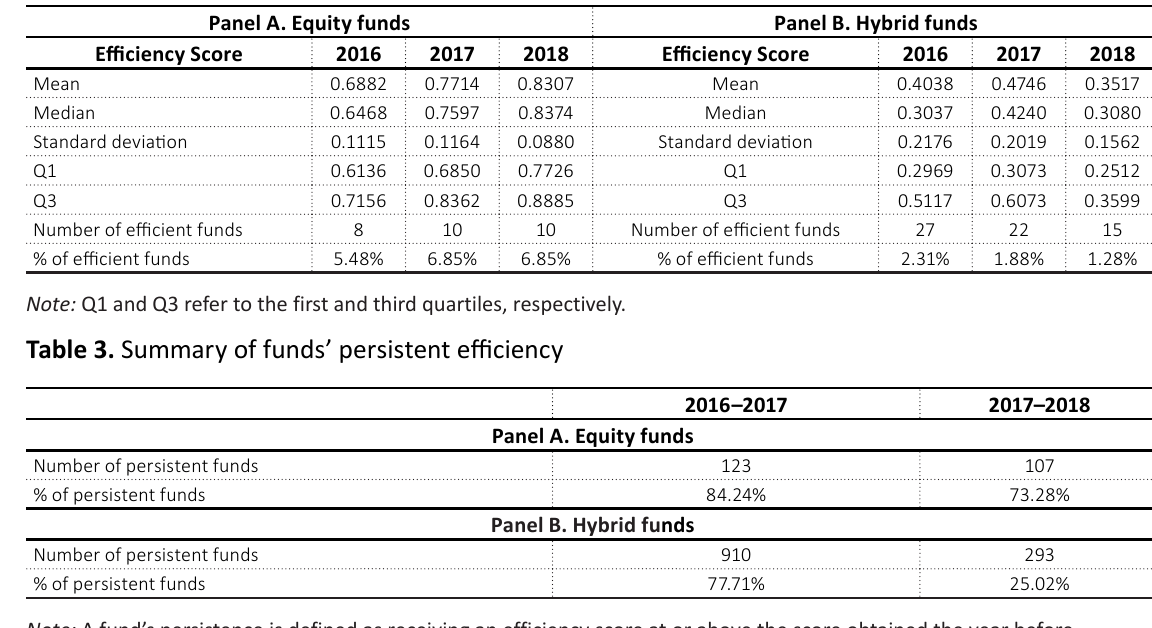
Table 2. Summary of the efficiency scores of equity and hybrid funds